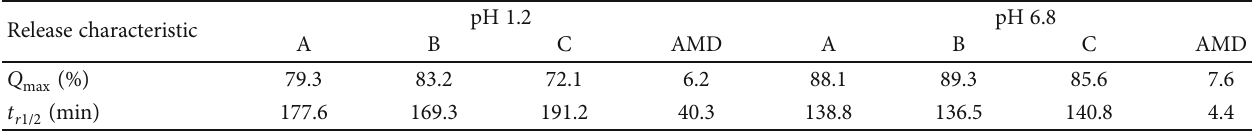
Table 6: Drug release parameters of the inclusion complexes (AMD/HP- β -CD A, AMD/HP- β -CD B, and AMD/HP- β -CD C) and pure AMD. Release characteristic